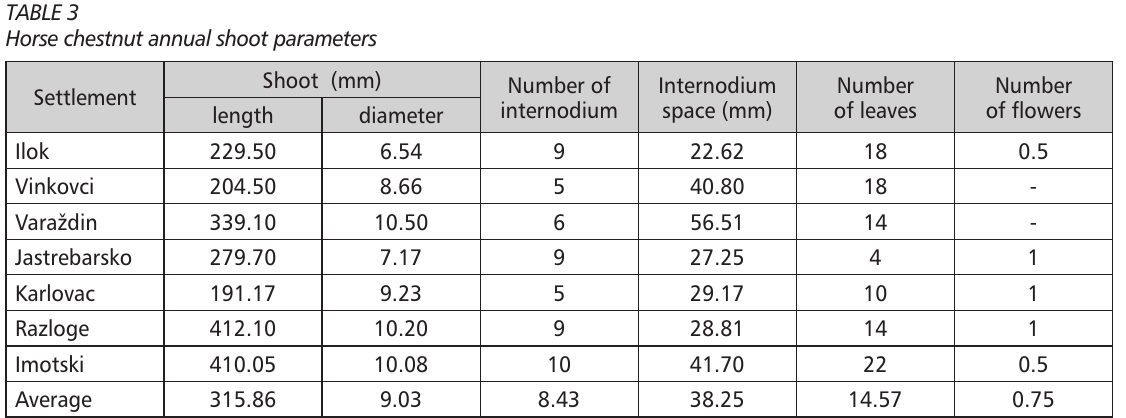
had the least width while the leaves measured in